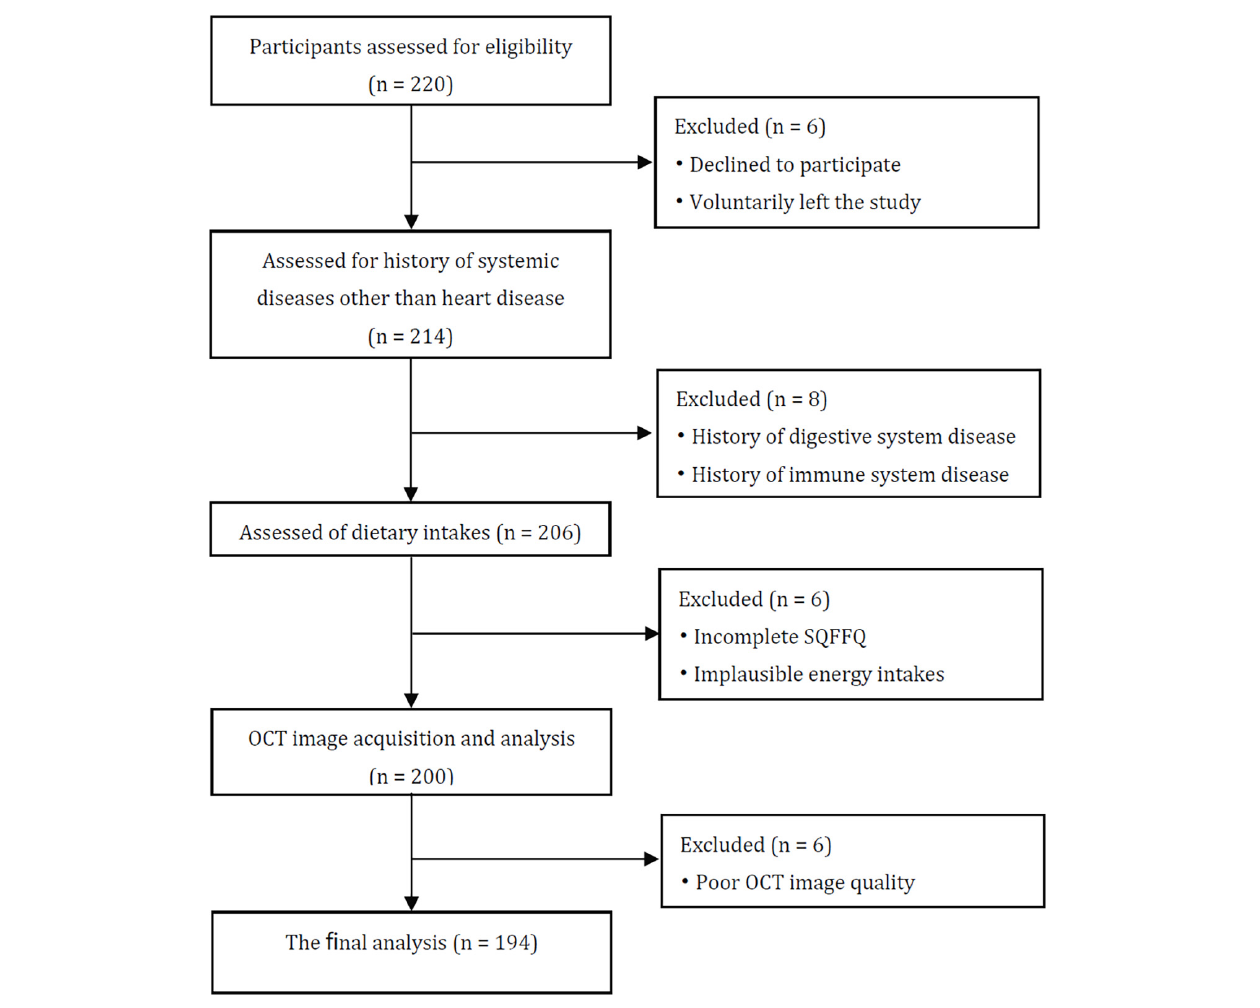
FIGURE 1 | Consort flow diagram. SQFFQ, Semi-quantitative food frequency questionnaire; OCT, Optical coherence